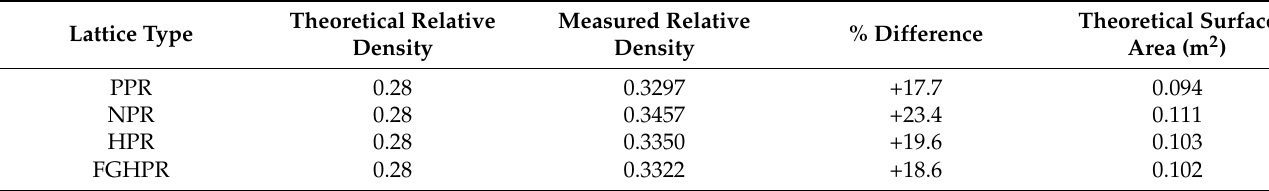
Table 3. The theoretical and measured relative density.